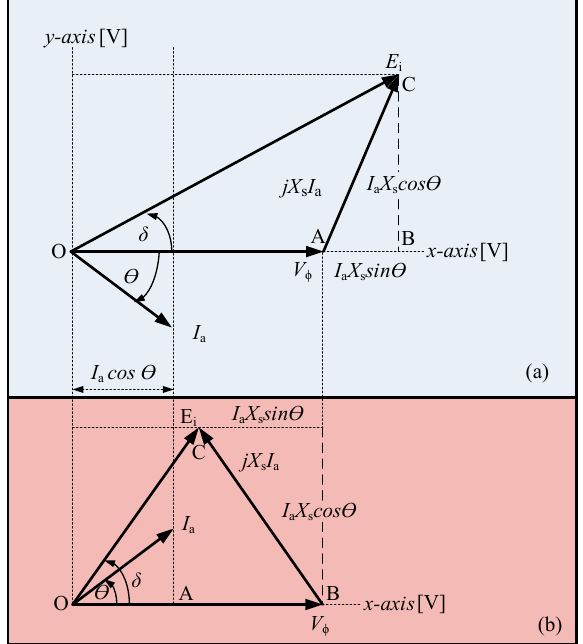
Figure 1. Generator phasor diagram [18]: ( a ) over-excited generator sends reactive power to the system, ( b ) Excited generator absorbs reactive power from the system.